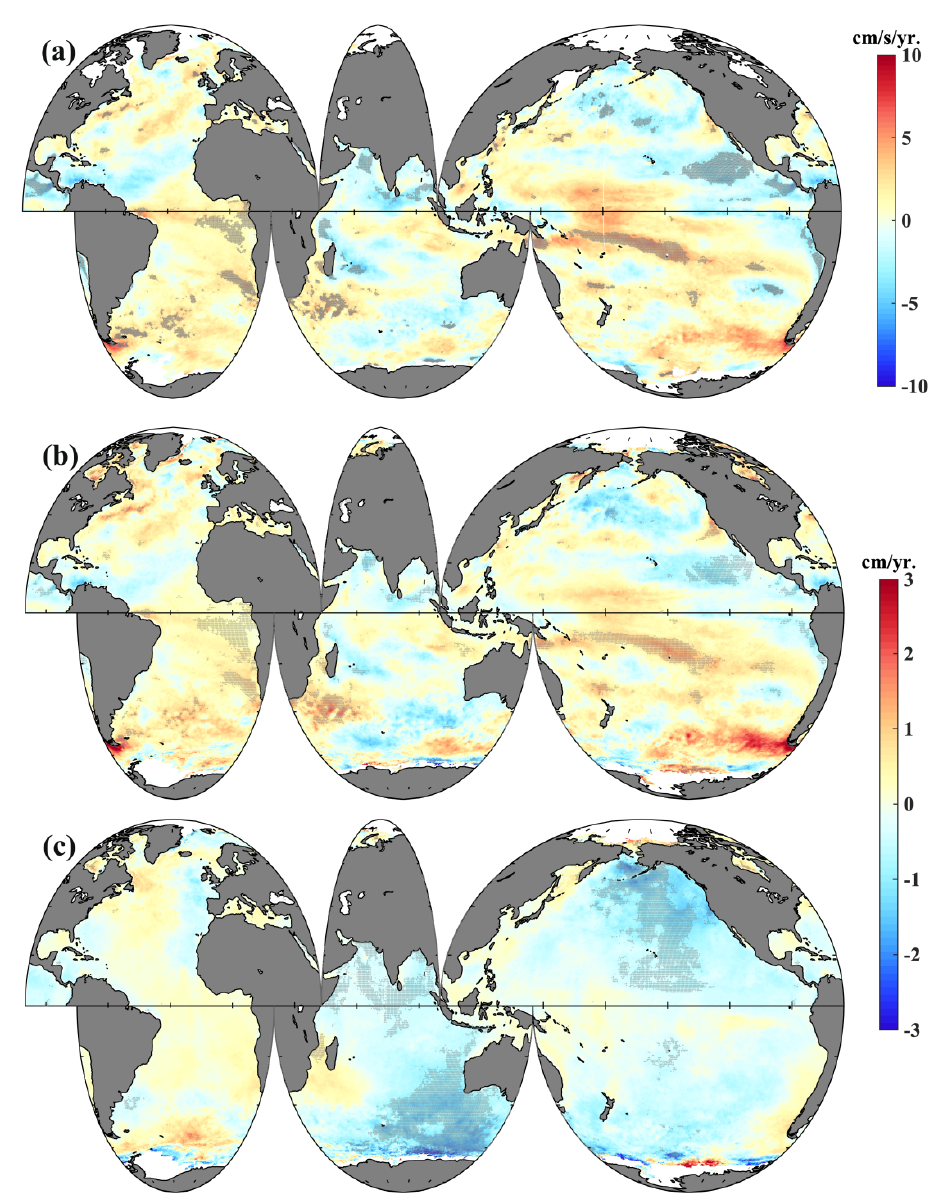
Figure 7. The linear trends in surface wind speed and significant wave height and its components during the global warming slowdown period: ( a ) spatial distributions of global annual mean surface wind speed trend, ( b ) wind wave height trend, and ( c ) swell wave height trend from ERA5. The grey shaded areas represent points that are statistically significant at ae 95% confidence level.